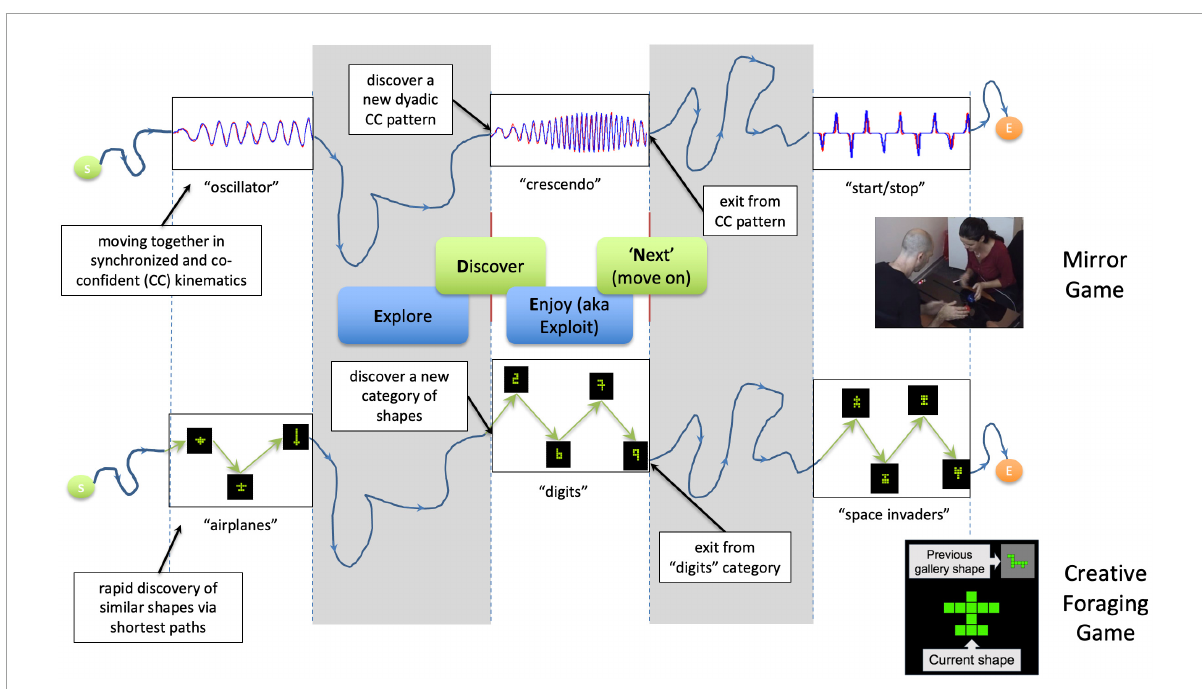
FIGURE1 The EDEN model. A theoretical model of creative exploration describes participants’ behaviors in two empirical paradigms, the mirror game (MG) and the creative foraging game (CFG). In iterative phases, participants first explore the space of possibilities in the game, then discover a stable pattern, exploit/enjoy it for a while, and then move on (next!), leaving the stable pattern and a return to exploration. In the MG (top row), a stable pattern is a specific dynamic of synchronized joint motions, termed co-confident (CC) motions; for example, a simple oscillation (top left), or the more complex “crescendo” (top middle). In the CFG (lower row), a stable pattern is a category of similar shapes that can have semantic similarity (e.g., “digits,” lower middle), or a more visual similarity (“space invaders,” lower right). A common question raised by the EDEN model is the “next!” point: what promotes participants to exit the current stable pattern and return to exploration? (adapted with permission from Noy,